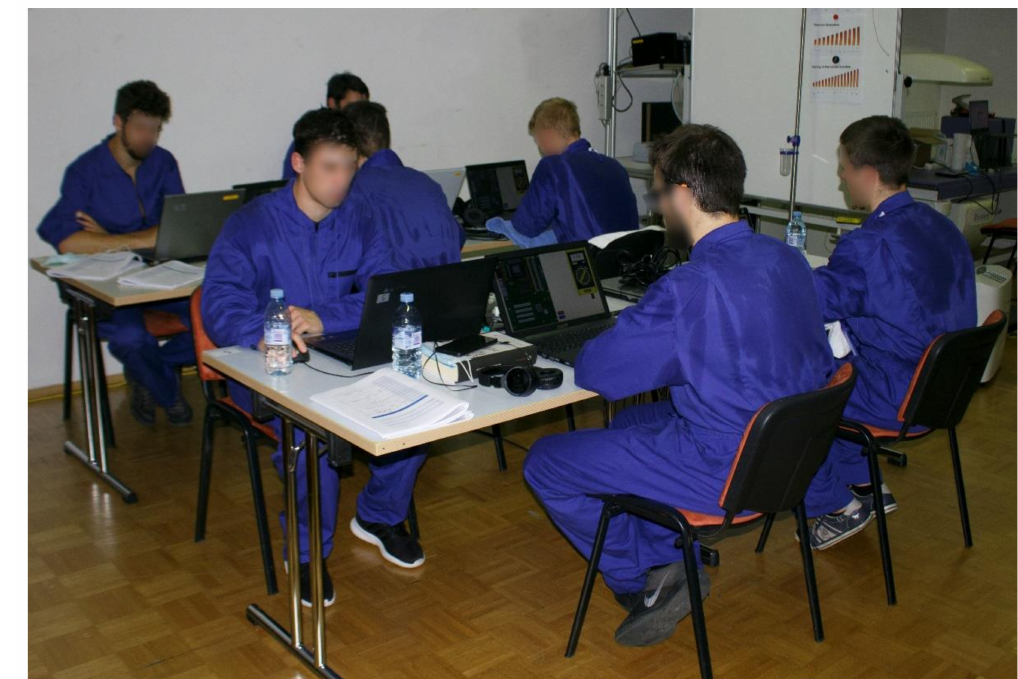
Figure A3. Simulated assembly line task being conducted during the heat-wave.